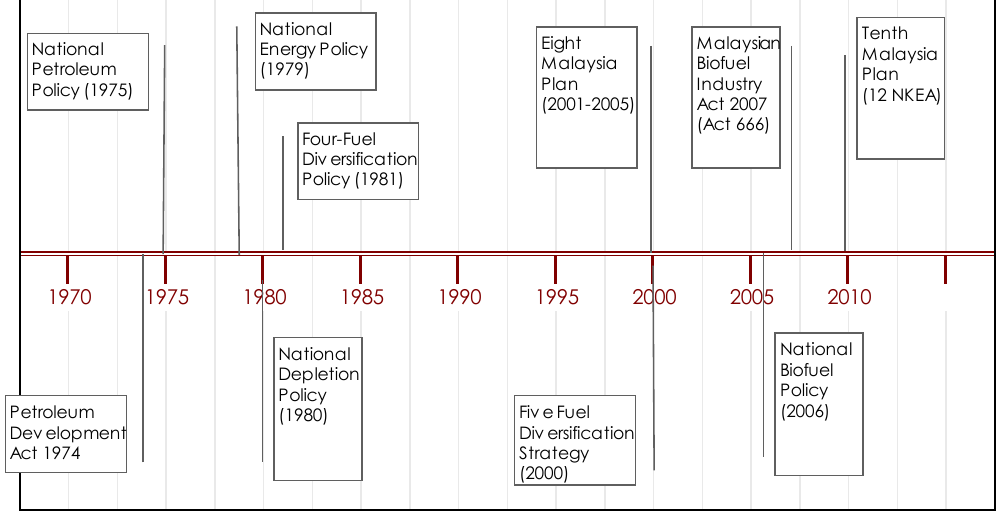
Figure 4. The timeline is a summary of the relevant initiatives in Malaysia leading to the National Biofuel Policy. The illustration here is the work of the